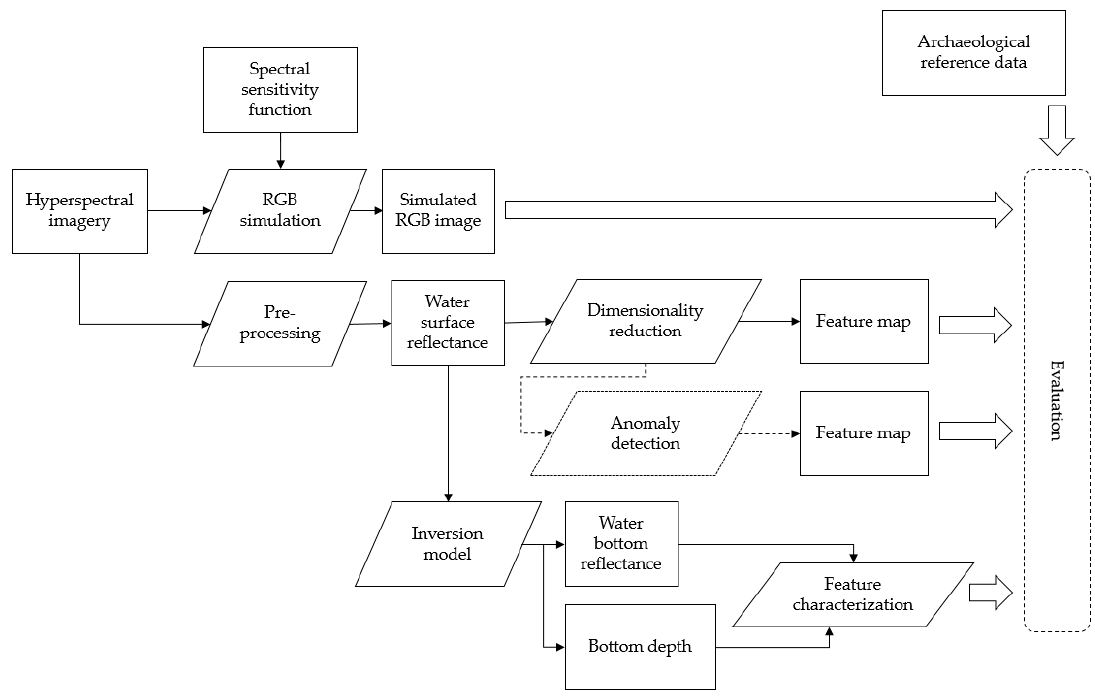
Figure 4. Diagram of the method developed.